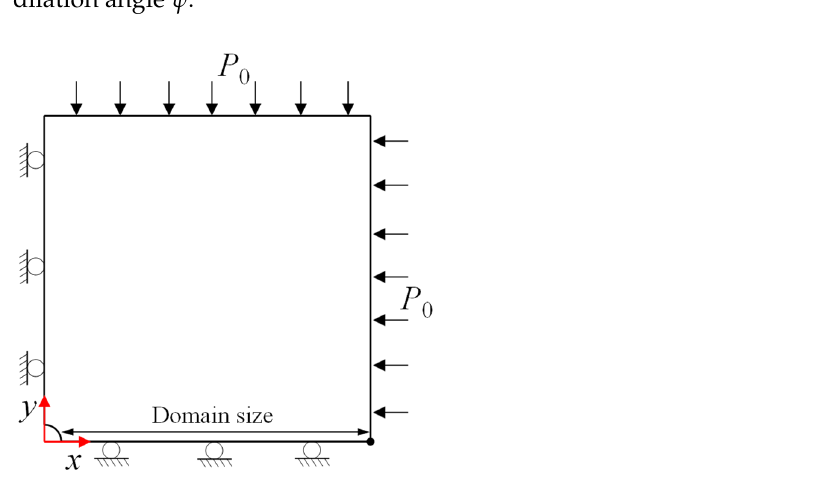
Figure A6. Physical plane strain model of a cylinder hole in an infinite MC material.